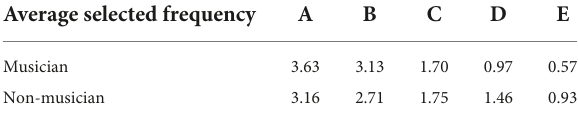
TABLE 2 Frequency statistics of audio material preference analysis of musician and non-musician subjects.